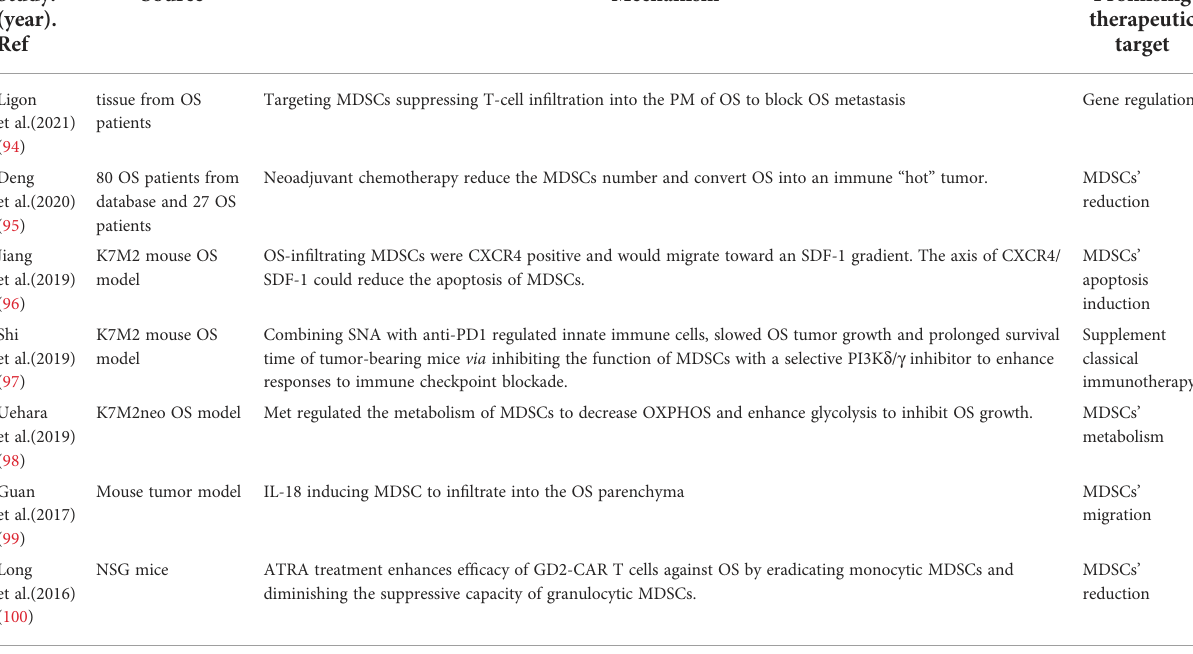
TABLE 4 A schematic diagram of promising therapeutic roles of MDSCs in OS.